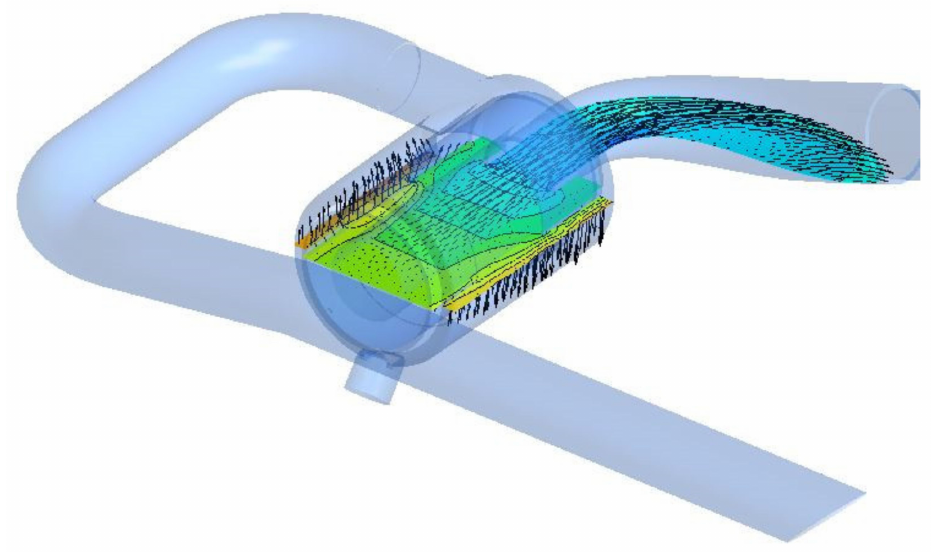
Figure 12. Velocity vectors and pressure contour on specific plan of air cleaner box at 4500 rpm condition.